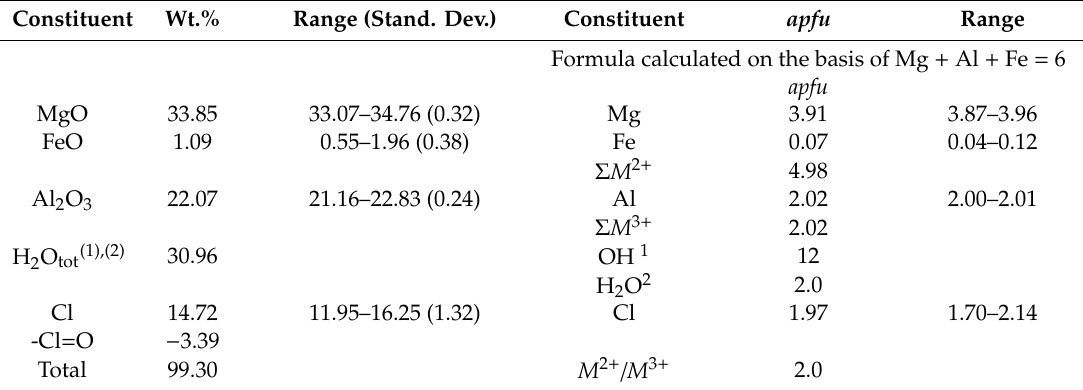
Table 2. Chemical composition of chlormagaluminite averaged for 15 analyses.